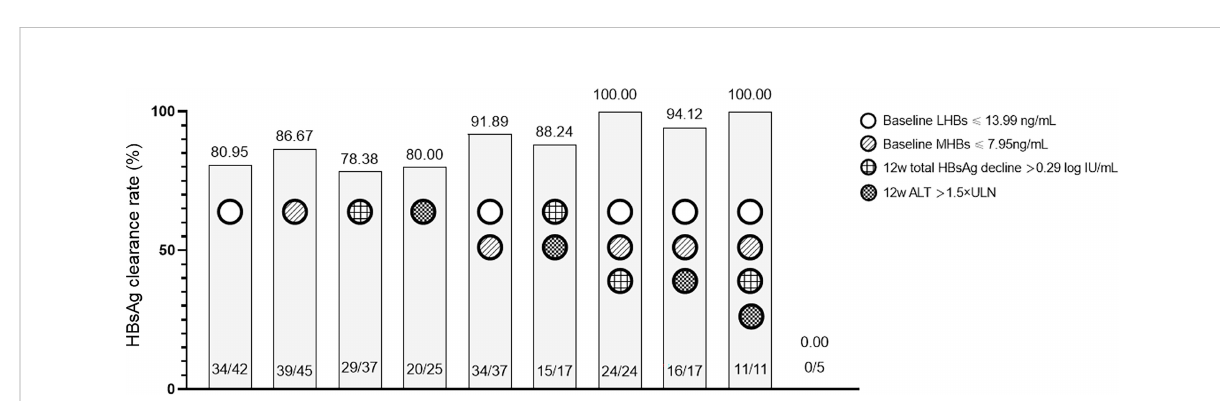
FIGURE 3 The predictive value of single and combined indicators for HBsAg